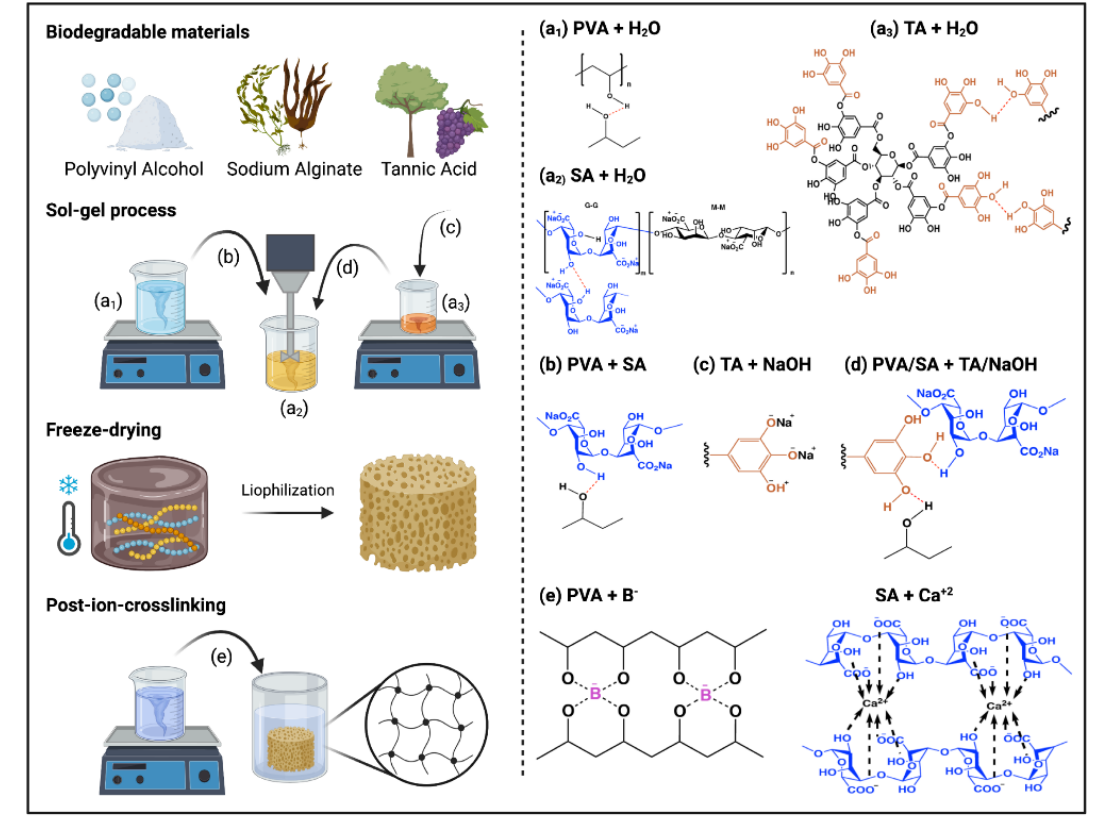
Figure 2. Schematic representation of the aerogels’ preparation process and the possible reactions between PVA/TA/SA aerogels and post-ion-crosslinking with CaCl 2 and H 3 BO 3 (Created with Bio- render.com Agrmt. No. EV240EKOH).